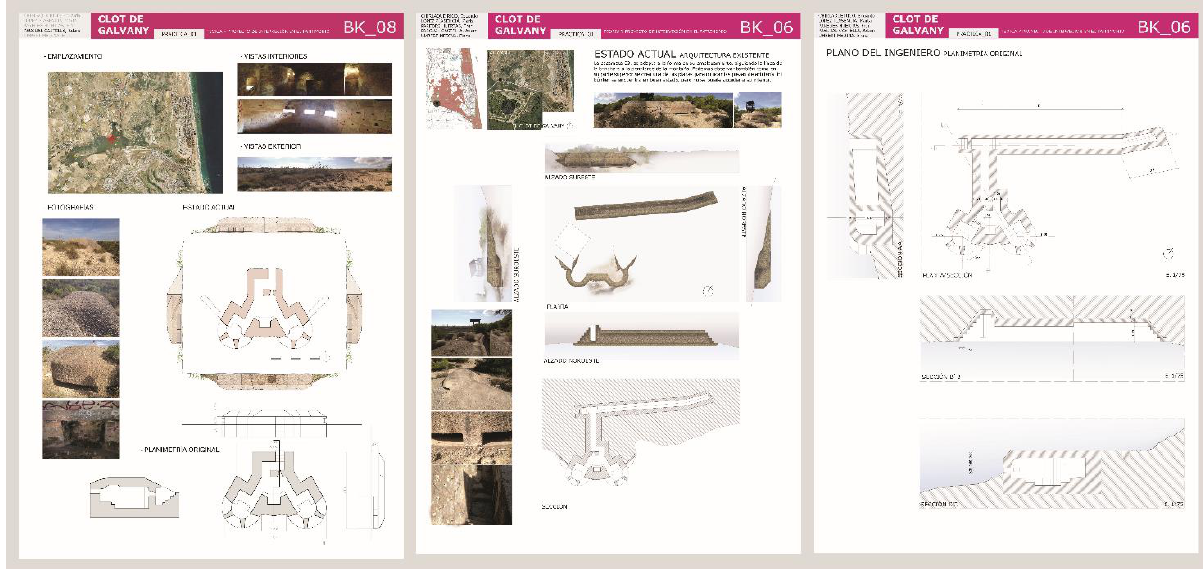
Figure 12.Part of the inventory of the defense elements of the Clot de Galvany to which will be extended the work of digital restitution of this military and industrial heritage, to put them in value through an interpretation center and an open-air